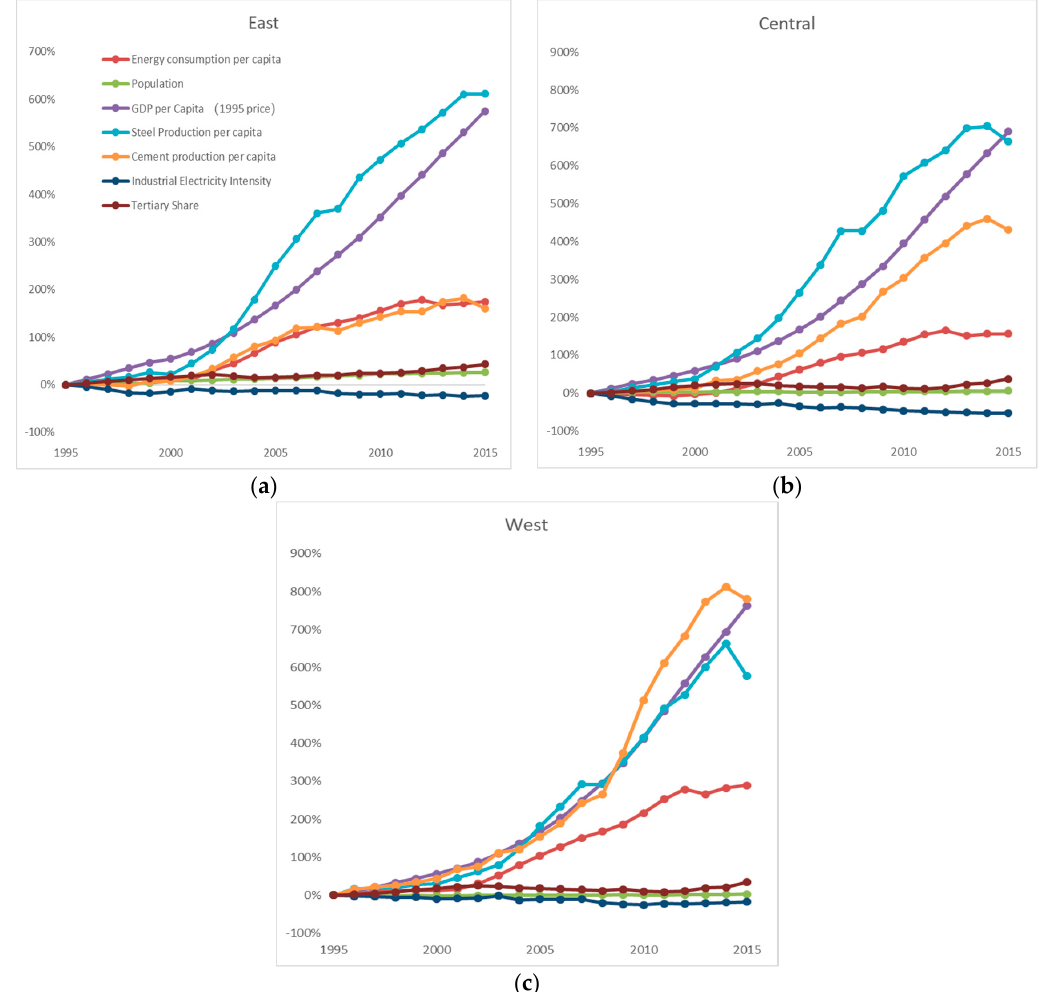
Figure 3. Trends of key variables from 1995 to 2015 by region.